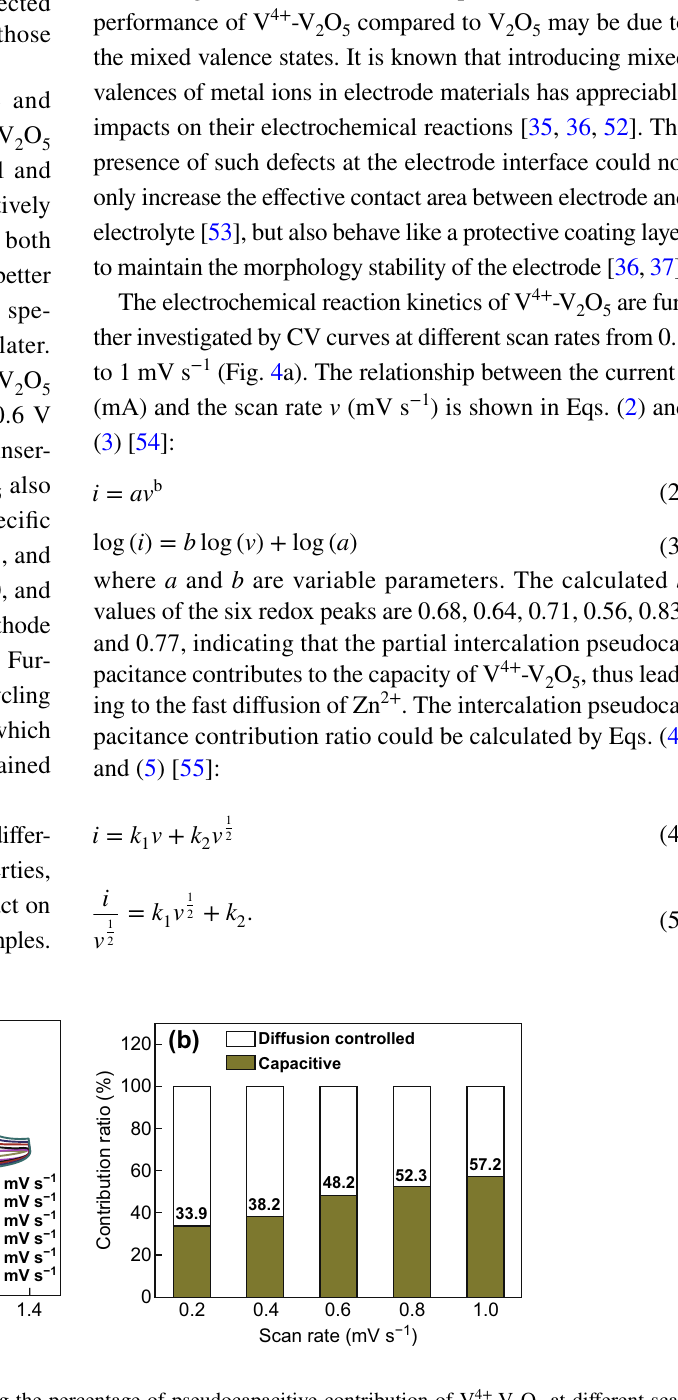
Fig. 4 a CV curves at different scan rates. b Bar chart showing the percentage of pseudocapacitive contribution of V 4+ -V 2 O 5 at different scan